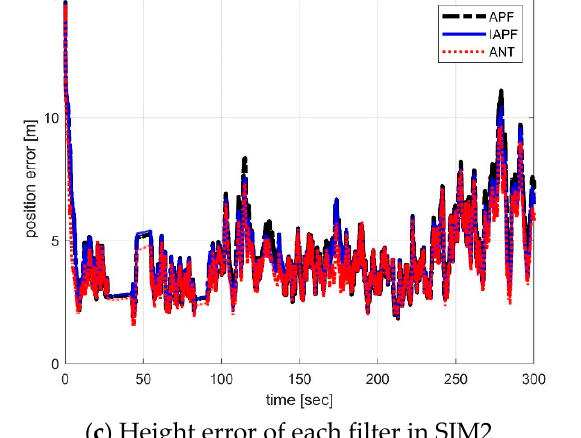
Figure 8. The position error plot of each filter in SIM2. ( a ) Longitude error of each filter in SIM2. ( b ) Latitude error of each filter in SIM2, ( c ) Height error of each filter in SIM2.